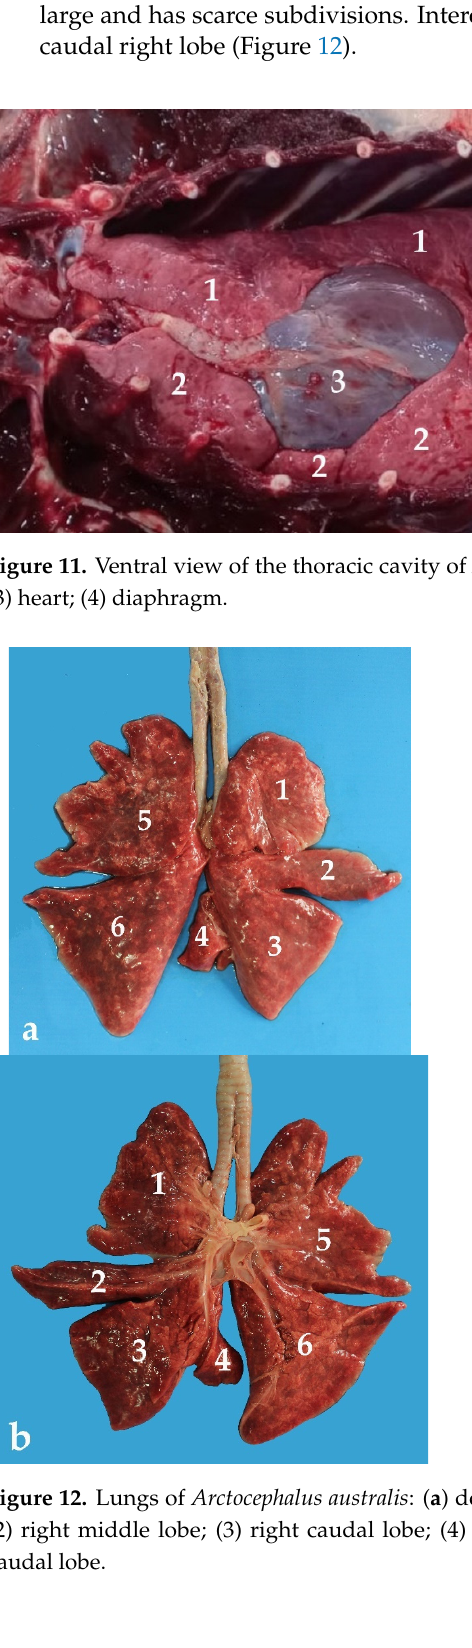
Figure 10. Ventral view of the lungs, washed with water and filled with compressed air: (1) right lung; (2) left lung.